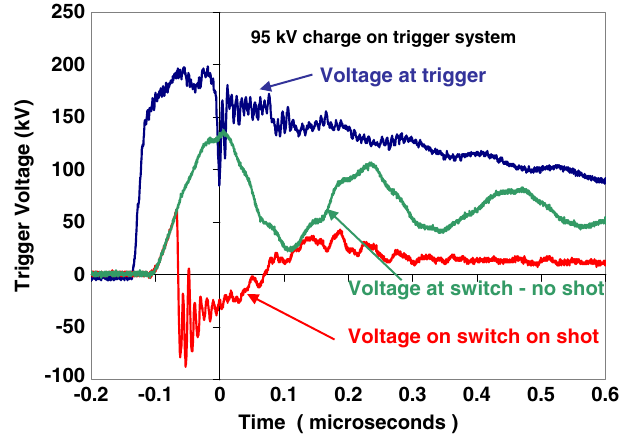
FIG. 12. Comparison of LTD-III trigger voltages measured at the trigger generator (blue), at a switch when no voltage was on the switch (green), and at a switch during an LTD-III shot